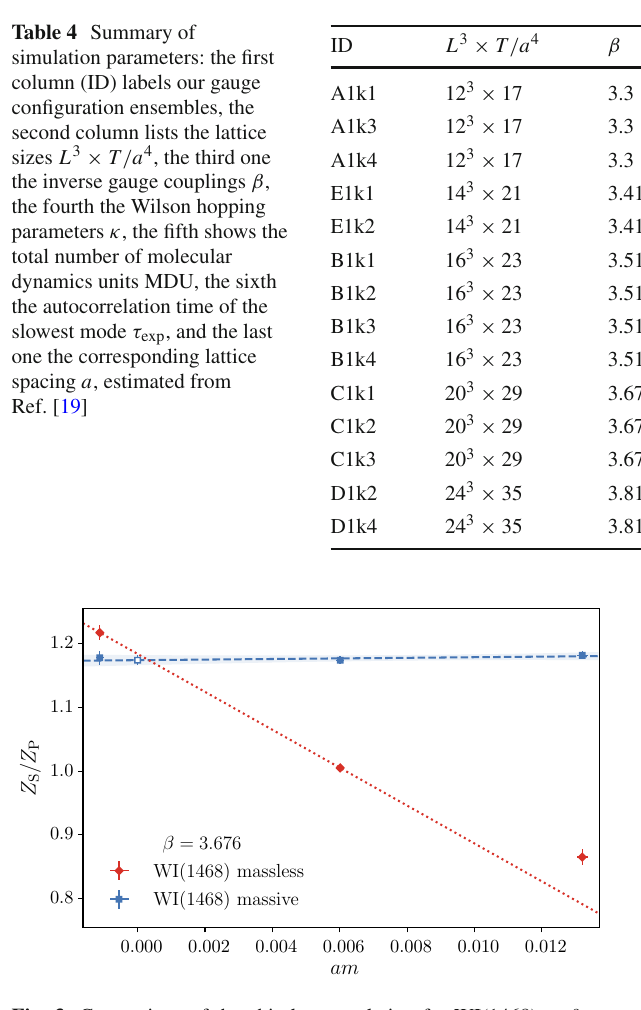
Fig. 3 Comparison of the chiral extrapolation for WI(1468) at β = 3 . 676withandwithoutthetermproportionaltothemass.Inthemassless case the data cannot be described by a linear function in am for the full mass range. The dotted line visualises the chiral extrapolation of the massless data set excluding the outmost data point. When the mass term is included, the data shows no significant quark mass dependence. The slope of the linear fit function, shown as the dashed line, where the shaded area corresponds to the 1 σ uncertainty, is zero within